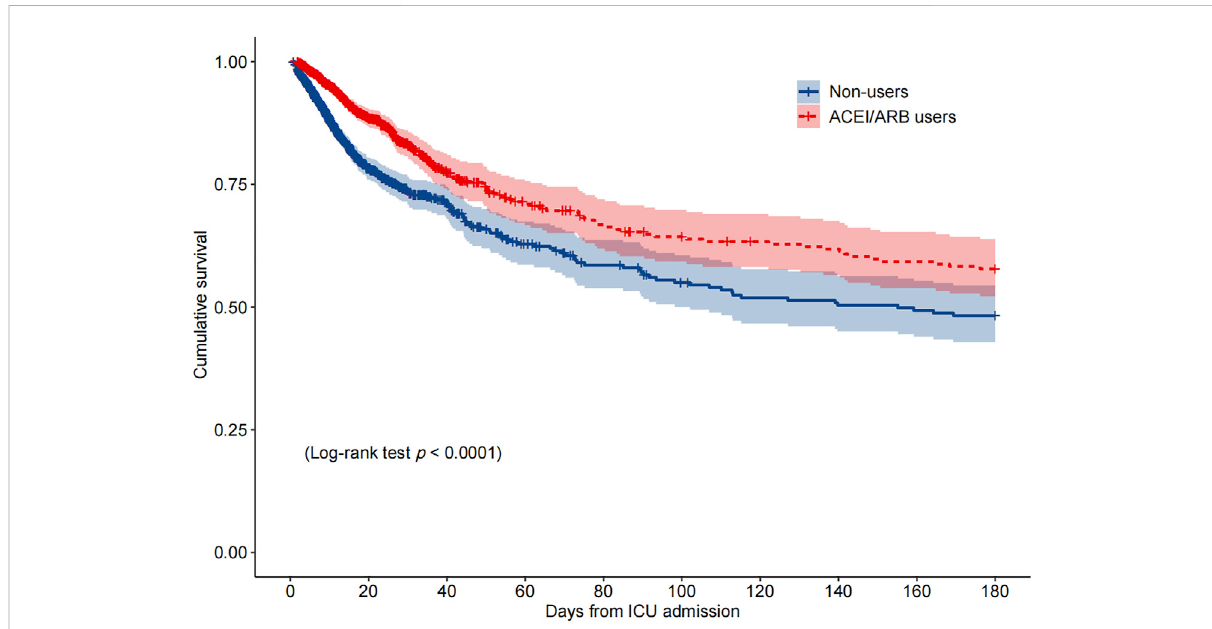
FIGURE 2 Kaplan – Meier survival curve for 180-day mortality by the ACEI/ARB status. p < 0.0001 by log-rank test. Abbreviations: ACEI, angiotensin- converting enzyme inhibitor; ARB, angiotensin receptor blocker; ICU, intensive care